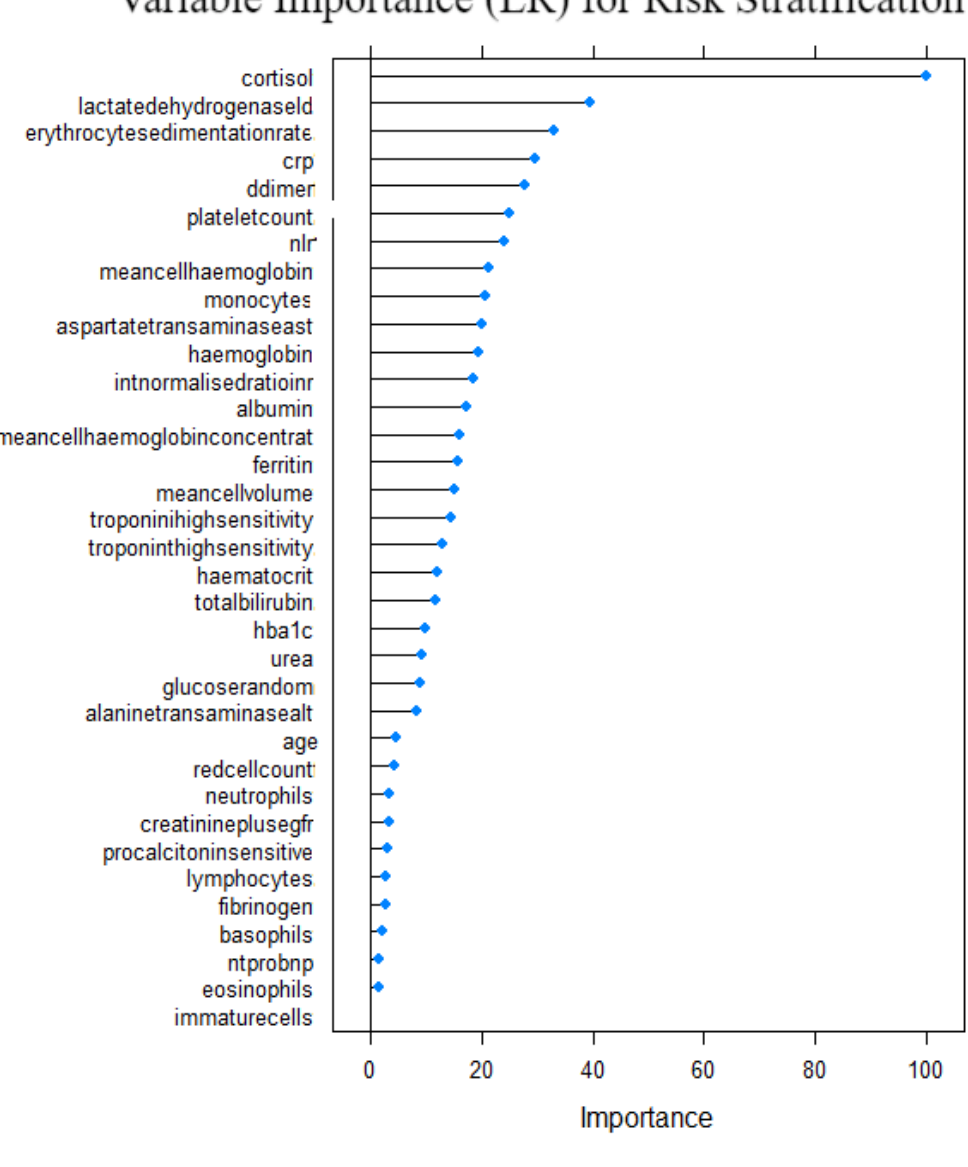
Figure 14. Variable importance from LR on risk